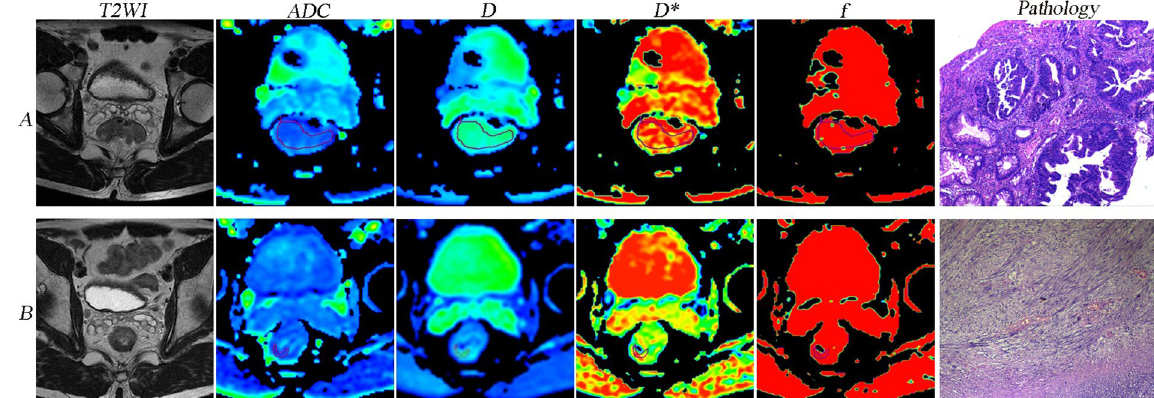
Figure 1. A LARC patient from the pCR and GR groups (TRG 4). Images in the row A and B are T2WI, IVIM-DWI parametric and pathological maps before and after nCRT, respectively. The ADC, D, D * and f values before nCRT were 1.07 × 10 − 3 mm 2 /s, 0.785 × 10 − 3 mm 2 /s, 47.7 × 10 − 3 mm 2 /s and 0.206, respectively. The ADC, D, D * , and f values after nCRT were 2.28 × 10 − 3 mm 2 /s, 1.81 × 10 − 3 mm 2 /s, 55.5 × 10 − 3 mm 2 /s and 0.248, respectively. The pathological map (haematoxylin-eosin staining, original magnification x40) after nCRT indicates the absence of residual cancer (TRG 4). LARC, locally advanced rectal cancer; pCR, pathological complete response; GR, good response; TRG, tumour regression grade; T2WI, T2-weighted imaging; IVIM- DWI, intravoxel incoherent motion diffusion-weighted imaging; nCRT, neoadjuvant chemoradiotherapy; ADC, apparent diffusion coefficient; D, pure diffusion coefficient; D * , pseudo-diffusion coefficient; f , perfusion fraction.